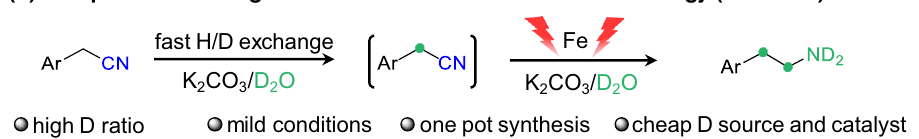
c and our proposed one-pot two-step deuteration strategy d for the synthesis of α , β -deuterated aryl